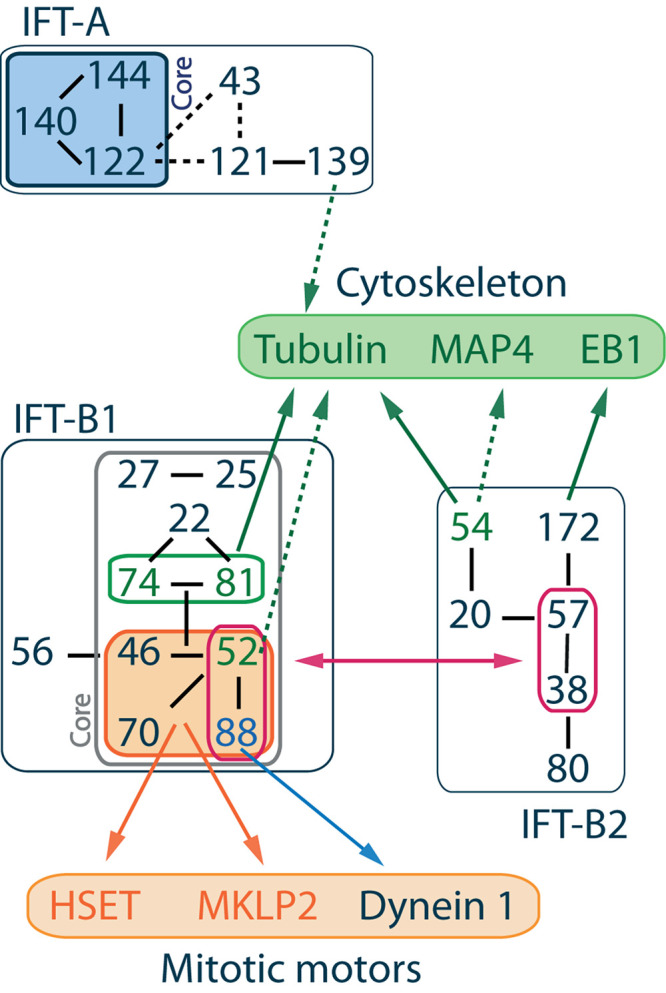
IFT complex overall organization and interactions with cytoskeleton components and mitotic motors. IFT proteins are divided into 2 classes. IFT-A complex is made of 6 subunits IFT144-140-139-122-121-43 where IFT144-140-122 form the core complex (Mukhopadhyay et al., 2010; Behal et al., 2012) and IFT139-120-43 form a peripheral subcomplex (Hirano et al., 2017). IFT-B complex is made of 16 subunits, and its overall architecture determined by VIP (visible immunoprecipitation) assays (Katoh et al., 2016), X-ray (Taschner et al., 2016), and interactome analysis (Boldt et al., 2016) reveals the presence of two stable subcomplexes. IFT-B1 is salt stable, its core complex is made of 9 subunits IFT88-81-74-70-52-46-27-25-22 (Lucker et al., 2005; Wang et al., 2009; Bhogaraju et al., 2011; Taschner et al., 2014; Wachter et al., 2019), while IFT-B2 is the peripheral complex made of 6 subunits IFT172-80-57-54-38-20 (Baker et al., 2003; Krock and Perkins, 2008; Taschner et al., 2016, 2018). The IFT-B2 central dimer IFT57-38 in association with the N-terminal domain of IFT52 and IFT88 mediates the interaction between both IFT-B subcomplexes (Taschner et al., 2016). Within IFT-B1, a stable tetrameric complex made of IFT88-70-52-46 was identified (Lucker et al., 2010; Taschner et al., 2011, 2014). Interactions between IFT machinery and mitotic motors are mediated by this tetramer (Delaval et al., 2011; Taulet et al., 2017; Vitre et al., 2020). Interactions with cytoskeleton components are mainly mediated by the IFT-B core complex, although the member of the IFT-A complex IFT139 is proposed to be a microtubule/tubulin binding partner (see text for details). Solid lines between IFT proteins indicate validated interactions, while dashed lines indicate putative interactions.